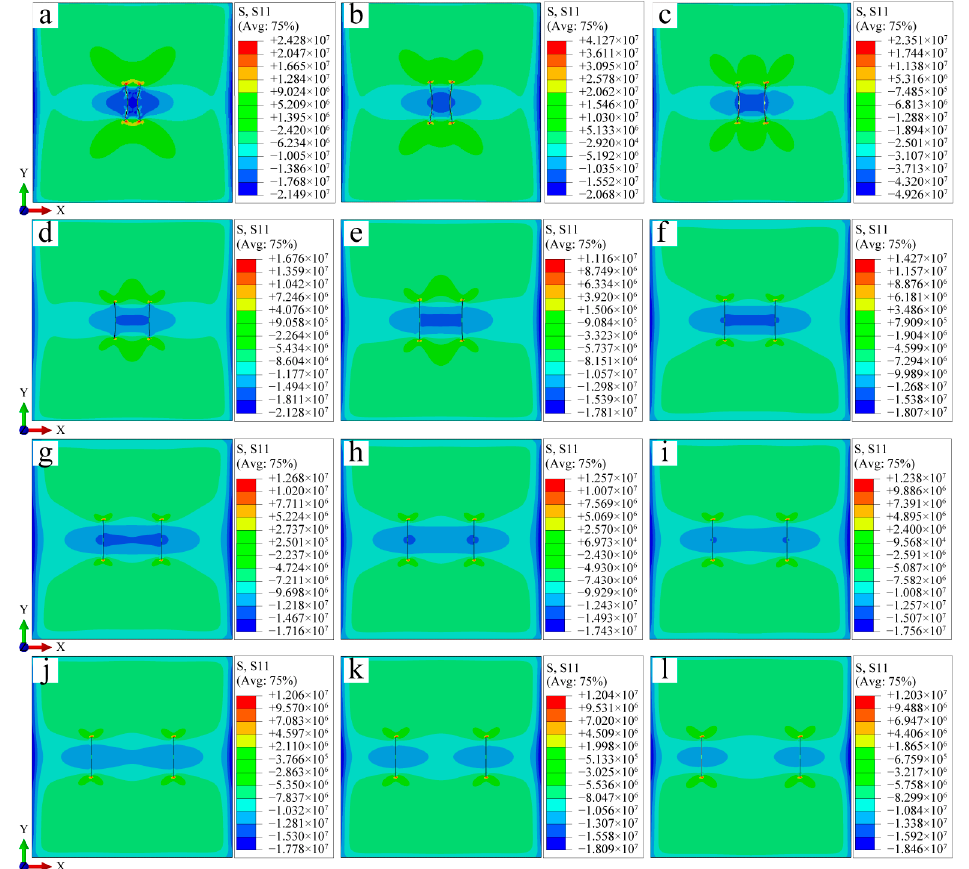
Figure 3. Horizontal stress contours with different perforation spacing at injection time of 10 s. There is a concentrated zone of compressive stress between the two perforations, which decreases with the increase in perforation spacing. ( a – l ) represents perforation spacing from 2 m–24 m, re- spectively.